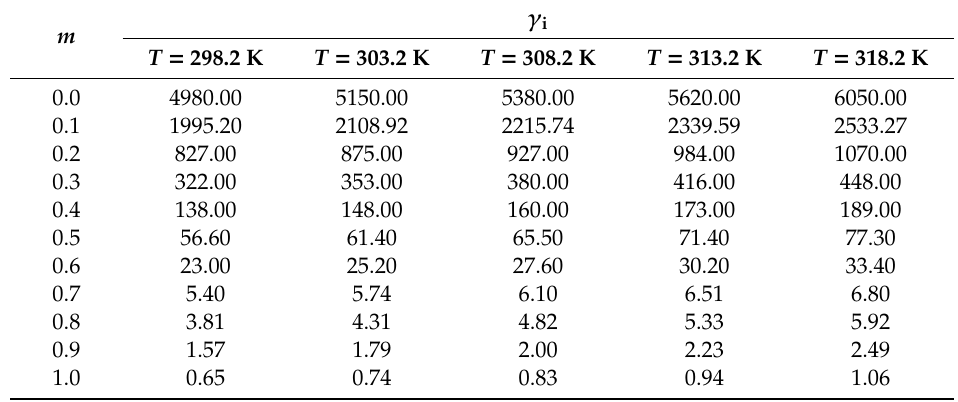
Table 2. Activity coefficients ( γ i ) of PPN in different “THP + water” mixtures ( m ) at “ T = 298.2–318.2 K”.